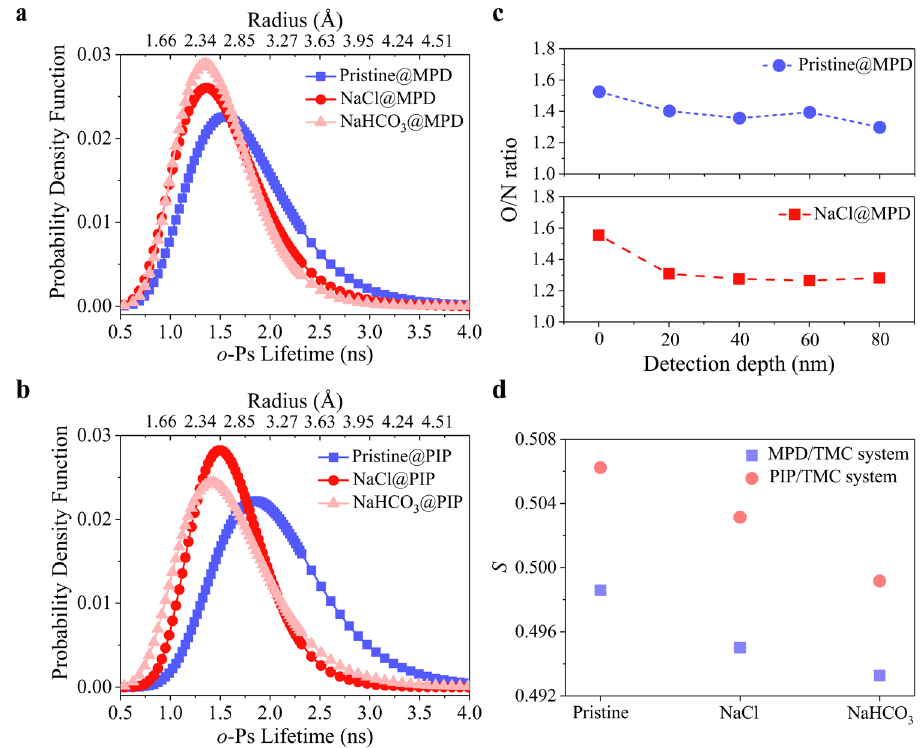
Fig. 2 Microstructural properties of the pristine and modi fi ed membranes. Free volume pore size distribution of the pristine and modi fi ed membranes formed by (a) MPD/TMC and (b) PIP/TMC. (c) In-depth O/N ratio pro fi les of membranes Pristine@MPD and NaCl@MPD. (d) S values of the pristine and modi fi ed membranes for both MPD/TMC and PIP/TMC monomer